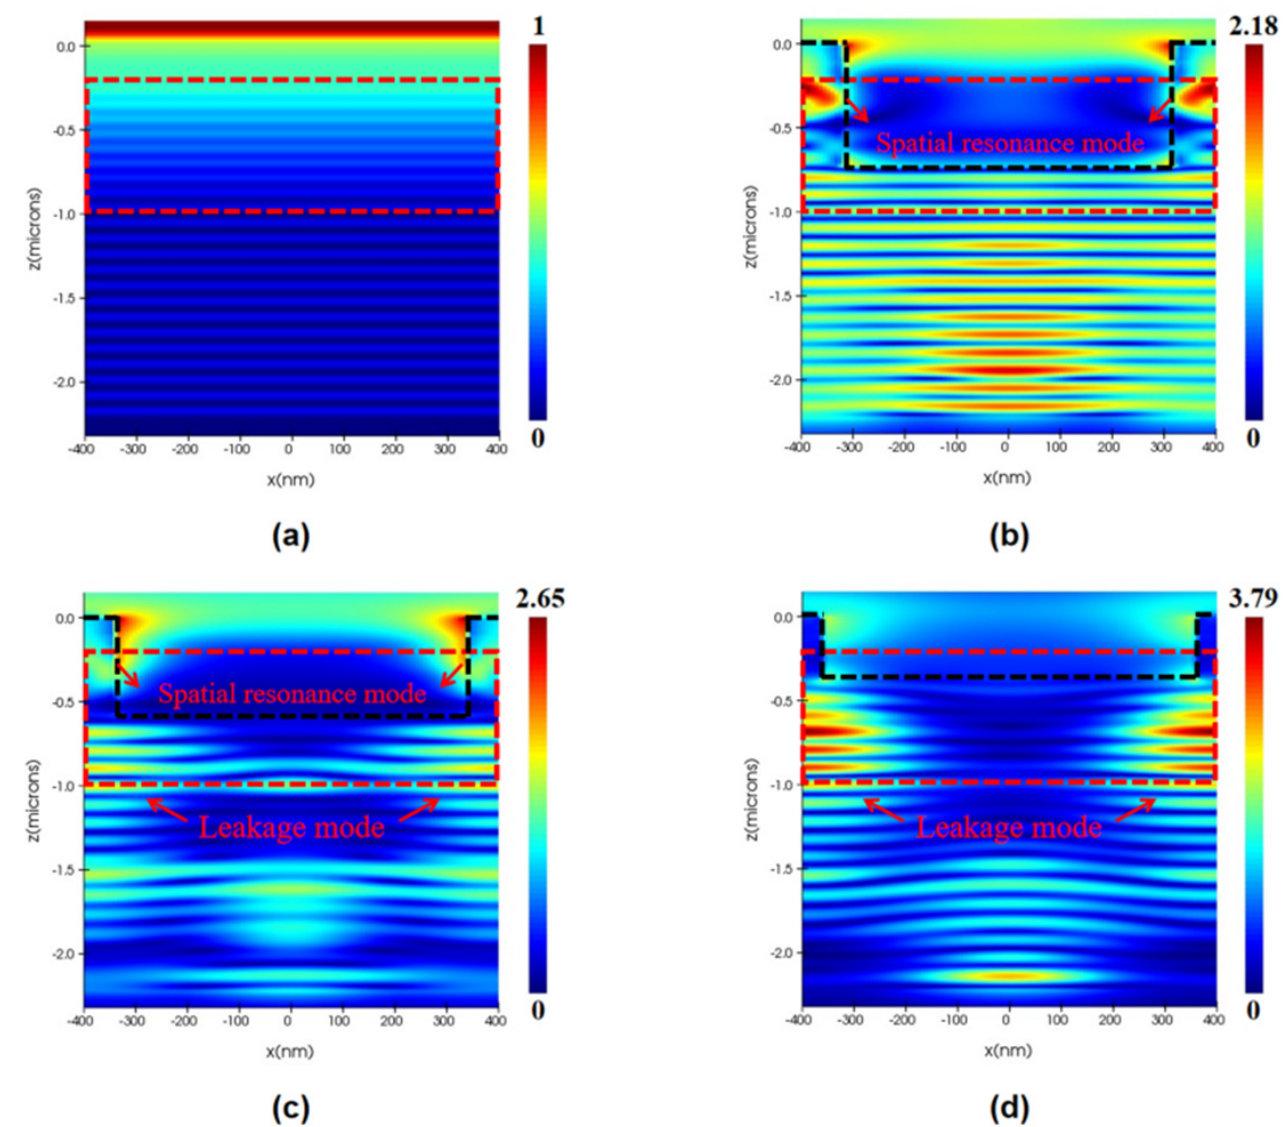
Figure 5. The Poynting vector distribution of the APD with ( a ) original structure, ( b ) D = 730 nm R = 320 nm PT structure, ( c ) D = 570 nm R = 340 nm PT structure, and ( d ) D = 380 nm R = 360 nm PT structure in the Z direction (the absorption layer is marked by the red dotted line, the SiO 2 hole is above the black dotted line).